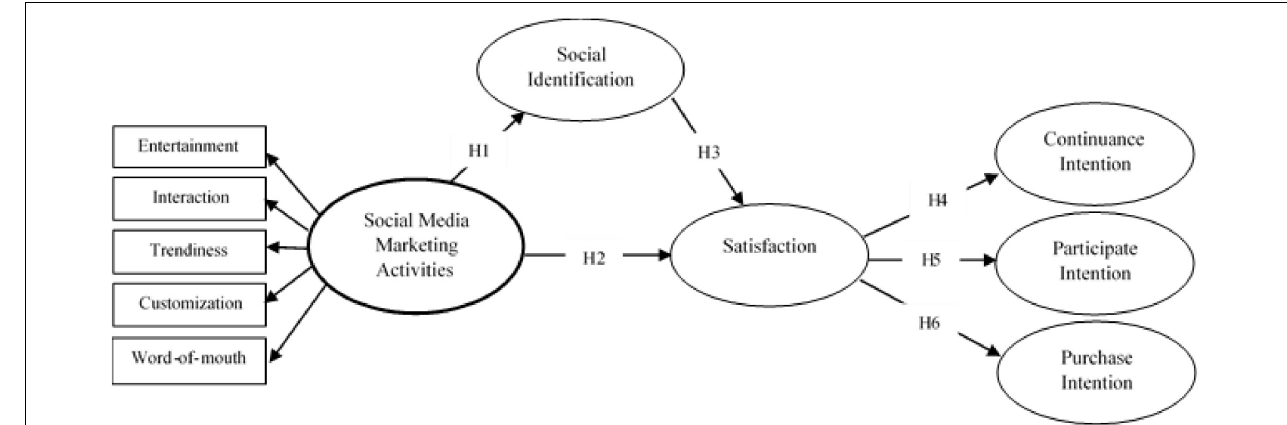
FIGURE 1 | Conceptual